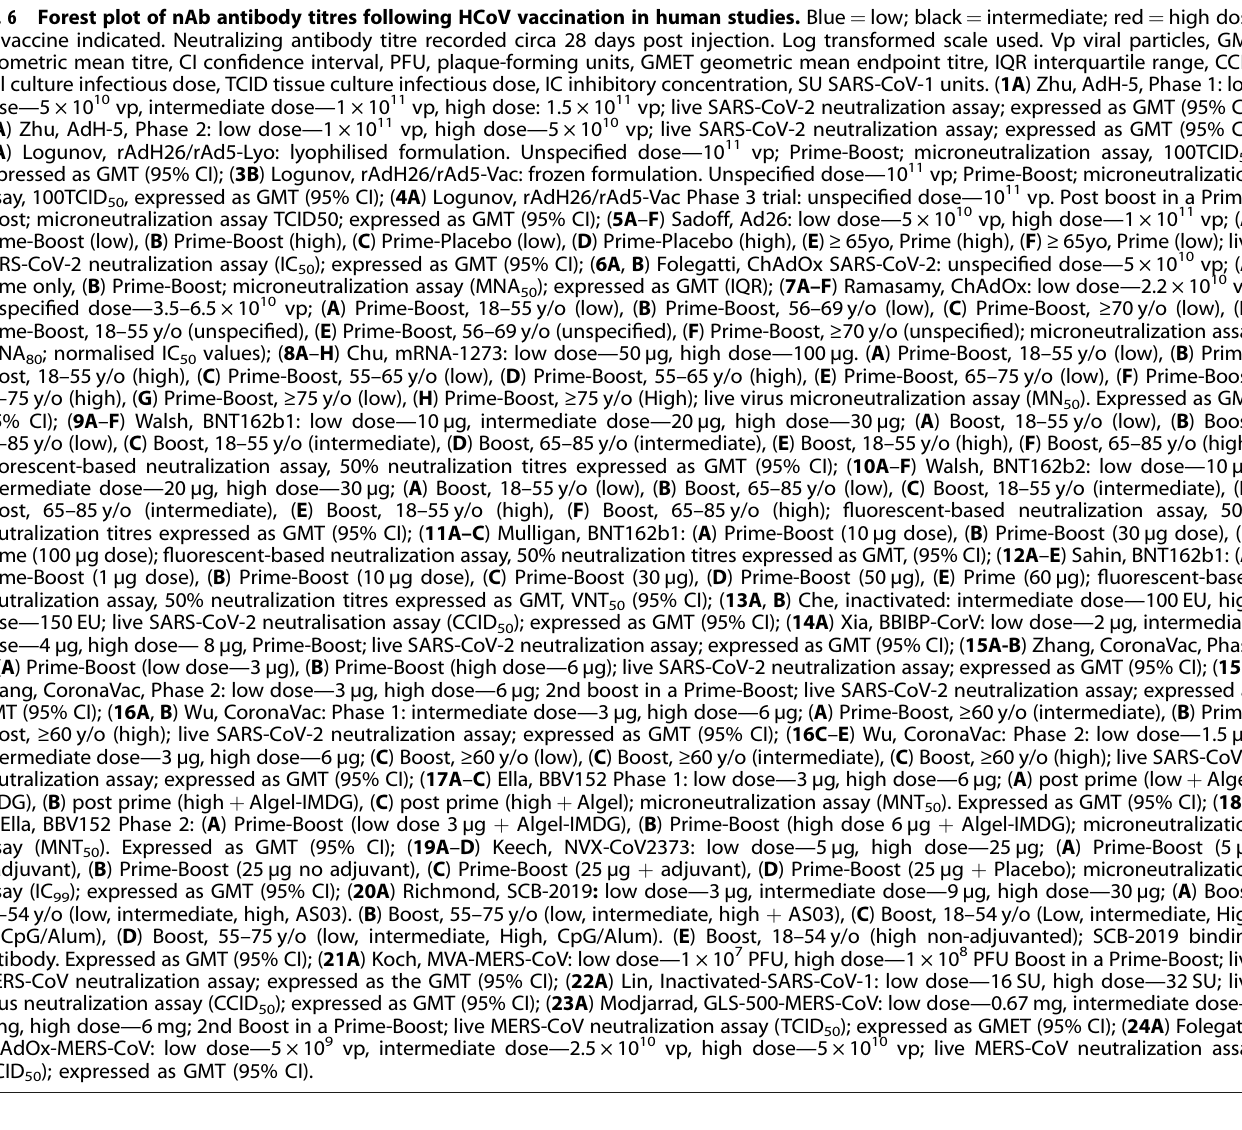
Fig. 6 Forest plot of nAb antibody titres following HCoV vaccination in human studies. Blue = low; black = intermediate; red = high dose of vaccine indicated. Neutralizing antibody titre recorded circa 28 days post injection. Log transformed scale used. Vp viral particles, GMT geometric mean titre, CI con fi dence interval, PFU, plaque-forming units, GMET geometric mean endpoint titre, IQR interquartile range, CCID cell culture infectious dose, TCID tissue culture infectious dose, IC inhibitory concentration, SU SARS-CoV-1 units. ( 1A ) Zhu, AdH-5, Phase 1: